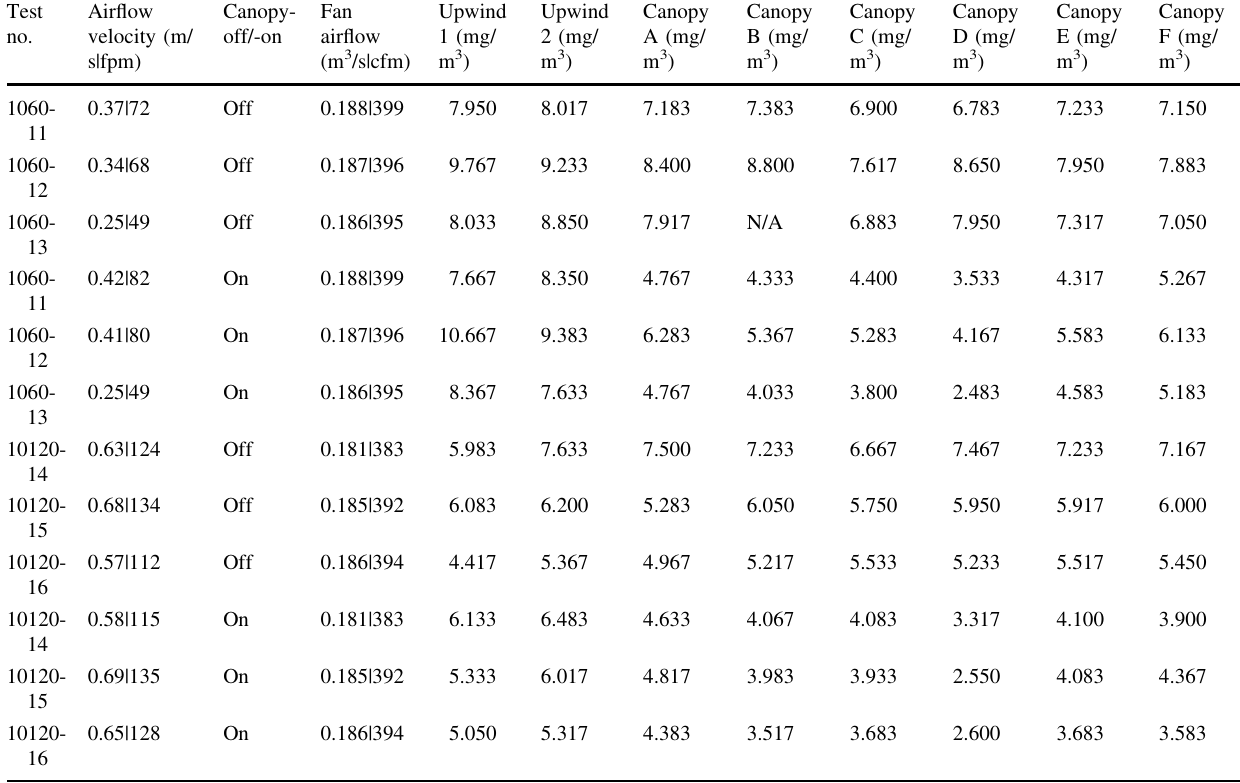
Table 6 Test data results for CAC at 10-in. height underneath the canopy using Medium Fan #2 Test